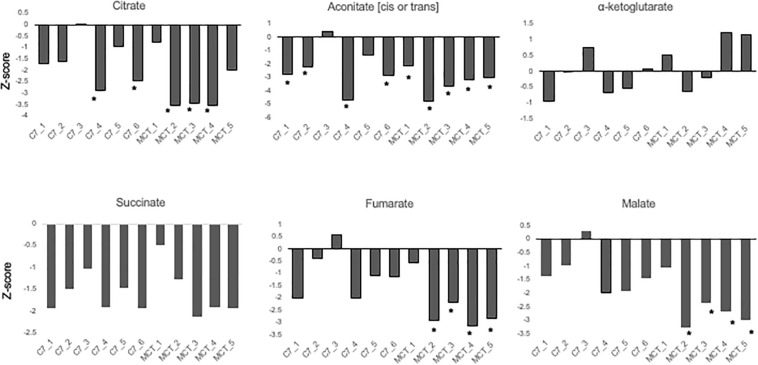
Concentrations of TCA cycle intermediates in the blood from VLCAD deficiency patients treated with standard MCT oil (MCT1–5) or triheptanoin (C1–6). The values are given as Z-score, defined as the number of standard deviations from age and sex matched control means.